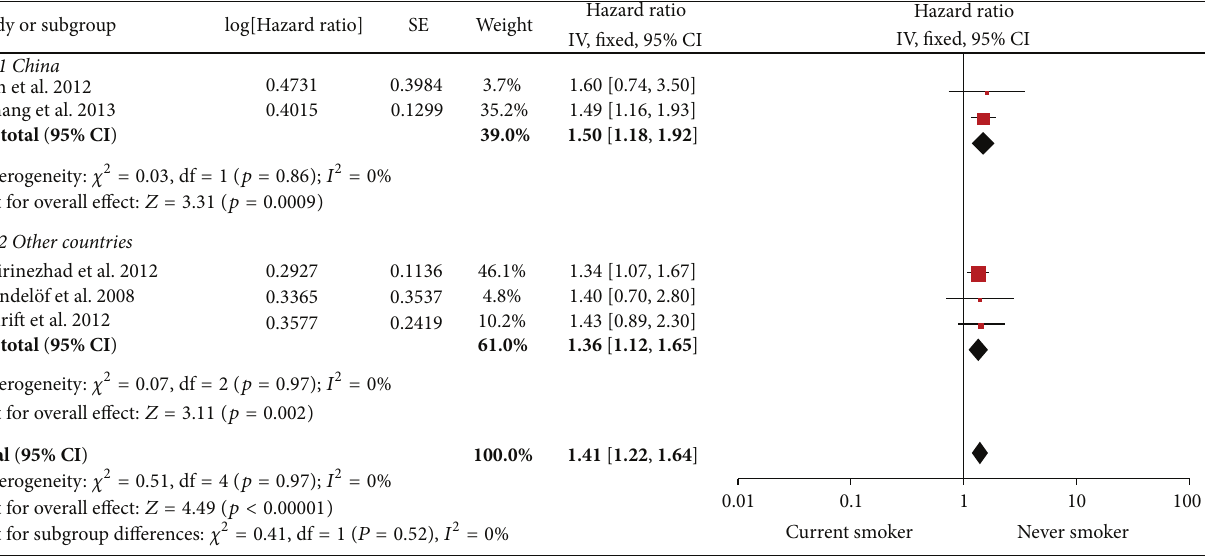
Figure 4: Subgroup analysis of current versus never smoker.